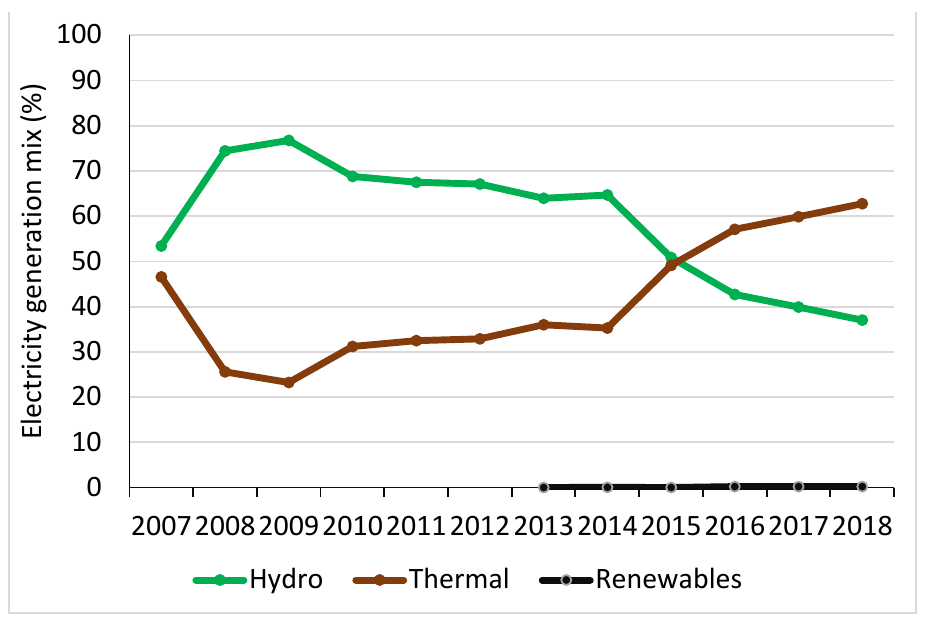
Figure 1. Trends in Ghana’s electricity generation mix, 2007–2018 [47,49].